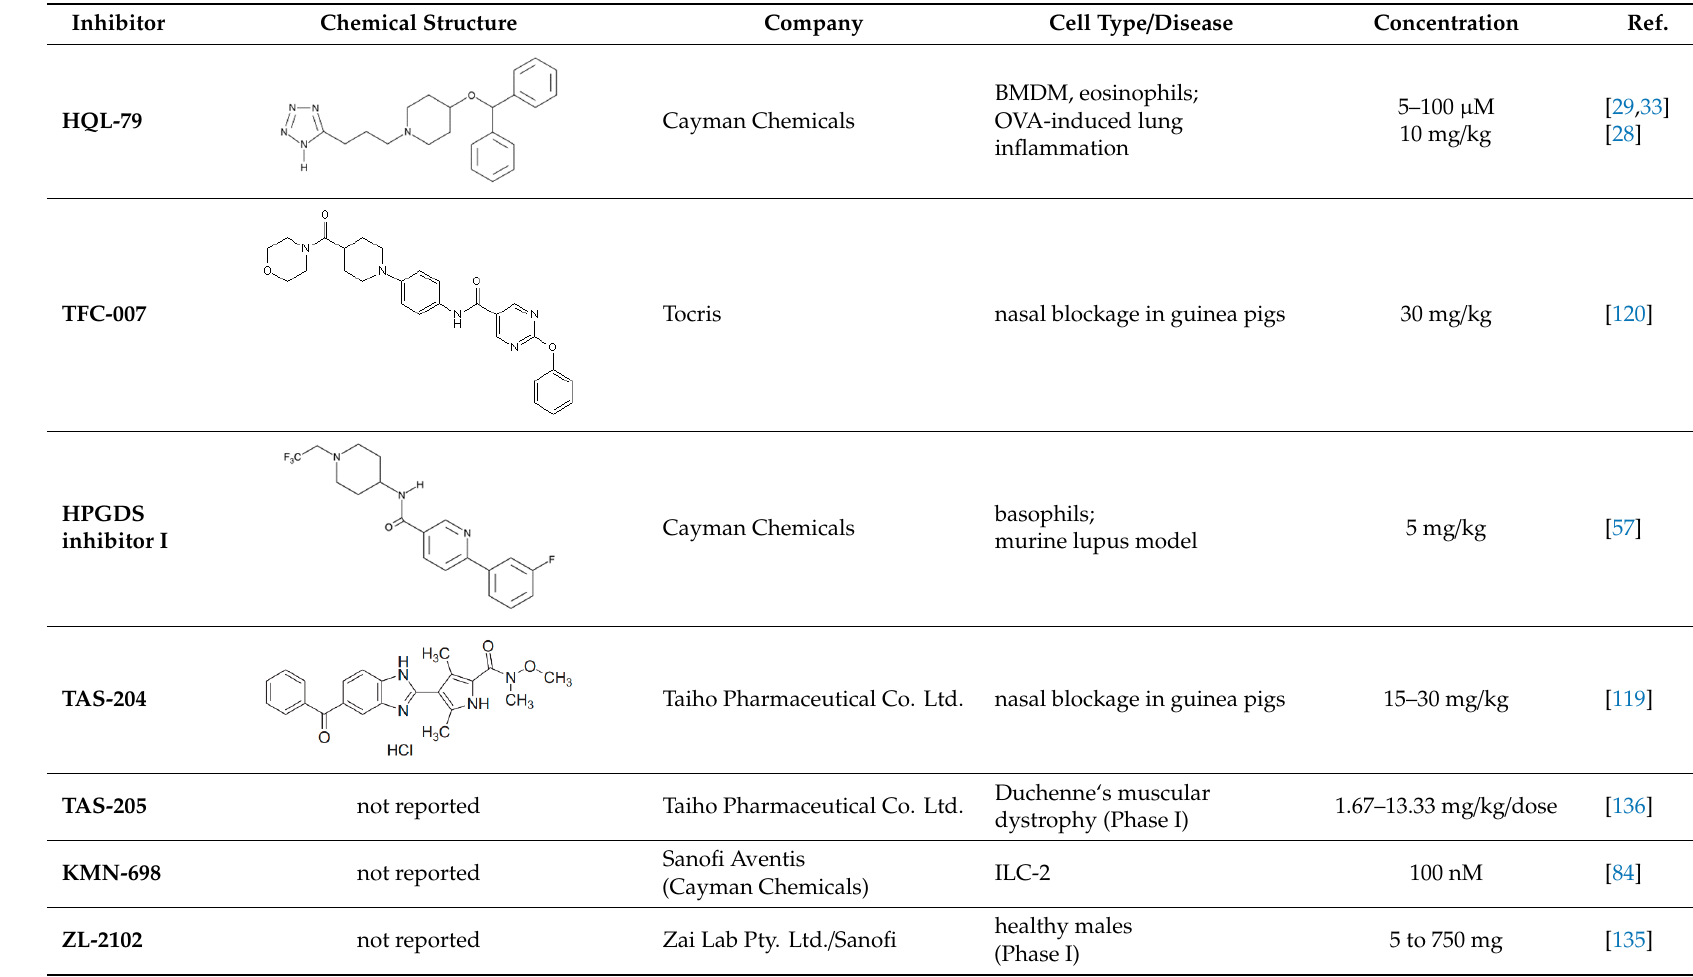
Table 2. hPGDS inhibitors and their cellular targets, effective concentrations and doses, and experimental settings reported in literature.